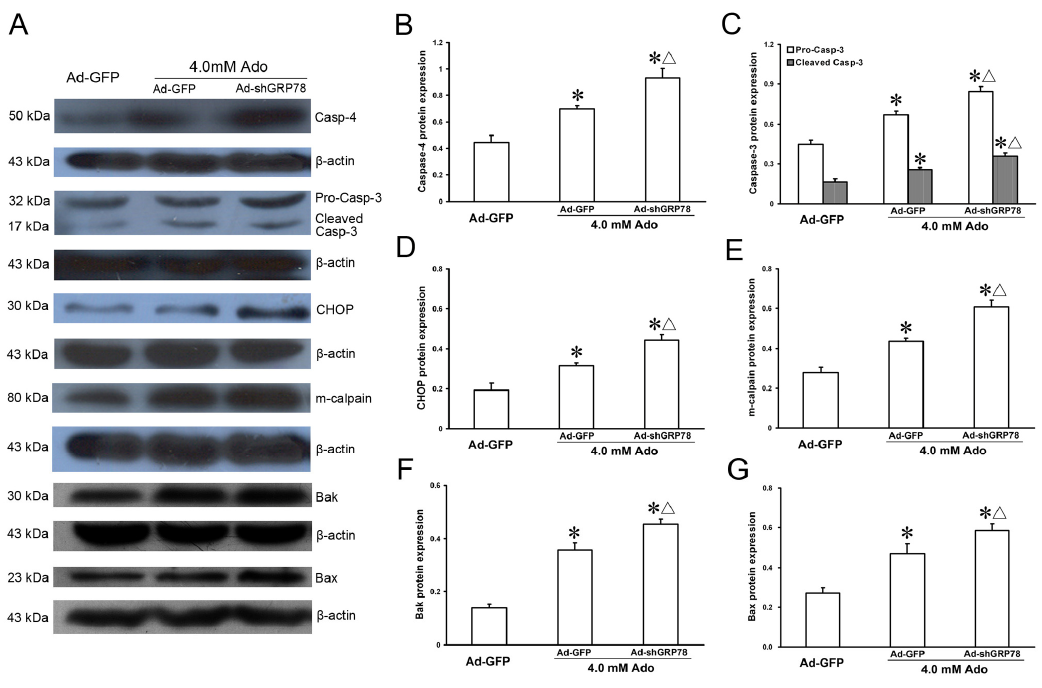
Figure 7. Effects of GRP78 knockdown on protein expressions of ER stress-related genes. HepG2 cells were transfected with either pAd-EGFP or Ad-shGRP78. After incubation for 24 h, cells were incubated with 4.0 mmol/L adenosine for a further 24 h. Cells transfected with Ad-GFP and without adenosine treatment served as a negative control. Protein expression of caspase-4, caspase-3, cleaved-caspase-3, CHOP, m-calpain, Bak, and Bax, were assessed by western blot ( A ); Adenosine caused protein expression increases in all ER stress-related genes examined. GRP78 knockdown further enhanced their protein expression ( B – G ). Data are presented as means ± SD of three independent experiments. Band intensity analysis was performed with Quantity One Software. * p < 0.05, vs. the negative control group; Δ p < 0.05, vs. the positive control